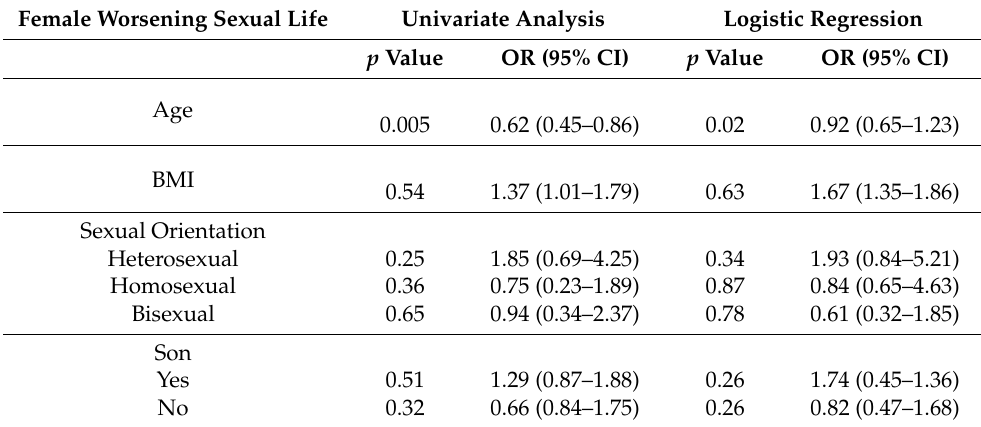
Table 7. Univariate analysis and multivariate logistic regression final model for female cohabitants worsening sex lives vs. demographic and psychological